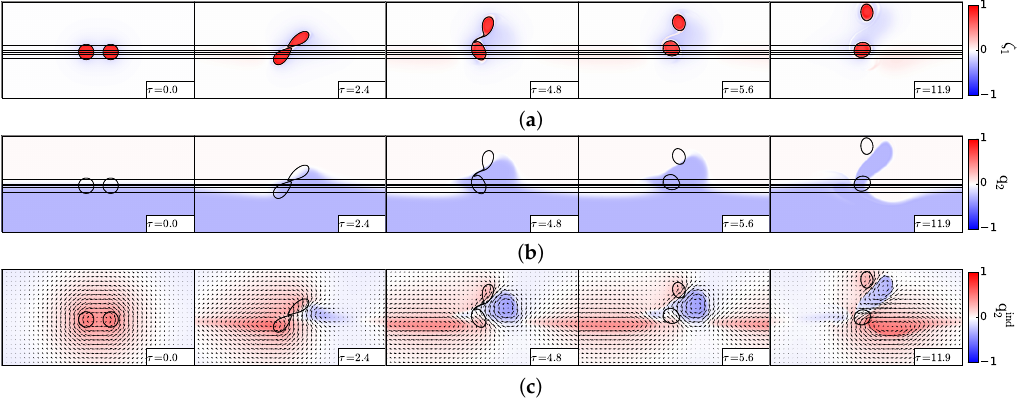
Figure 10. Separation of two cyclones, case d / R = 3.2, γ R = 1, d c / R = 0. ( a ) Upper layer relative vorticity (Equation (3)); ( b ) lower layer potential vorticity (Equation (2)); ( c ) lower layer “equivalent barotropic” potential vorticity (Equation (11)). The black contours indicate the topographic slope (Equation (12); straight lines) and the upper layer vorticity contours showing the two vortex